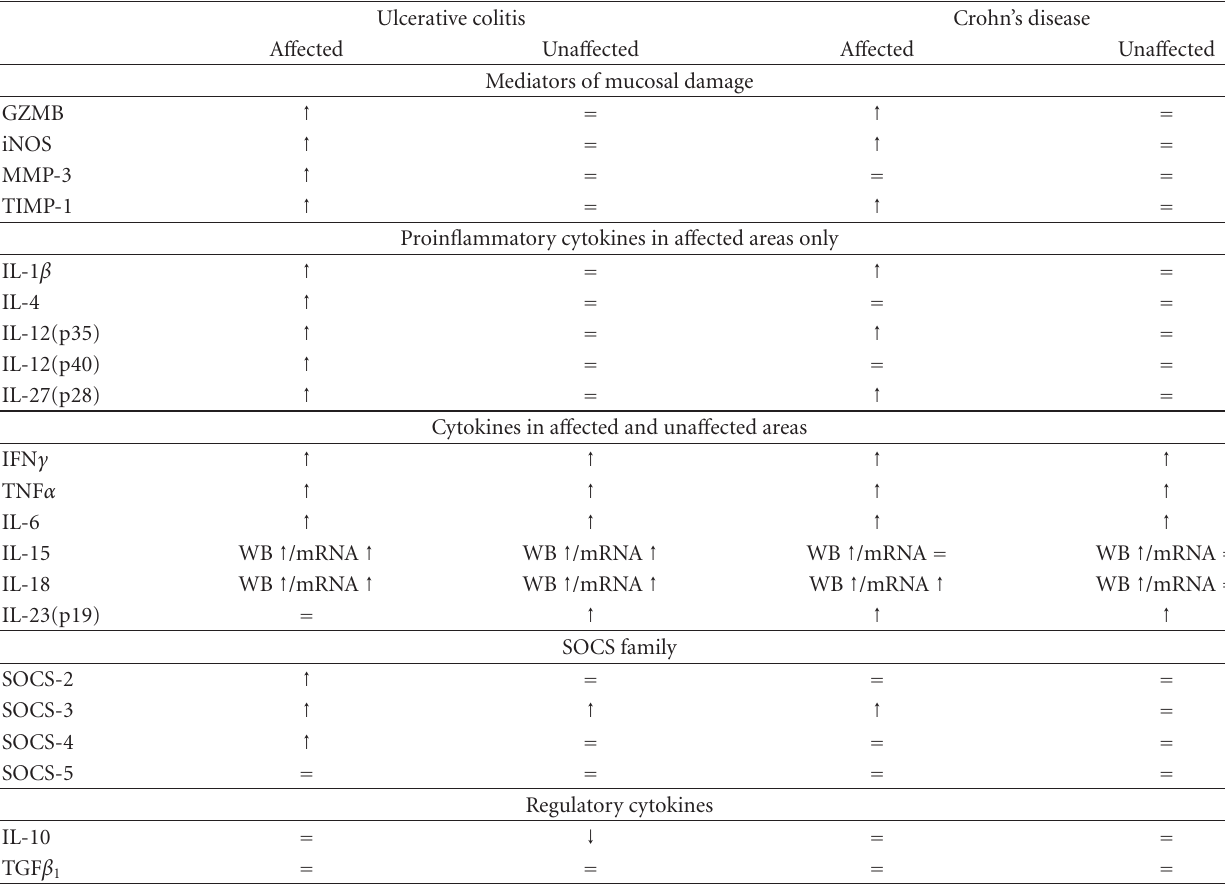
Table 3: Overview of mRNA expression in intestinal biopsies from UC and CD patients. ↑ , ↓ , and = : increased, decreased, or unchanged mRNA levels respect to healthy controls, Mann-Whitney P <